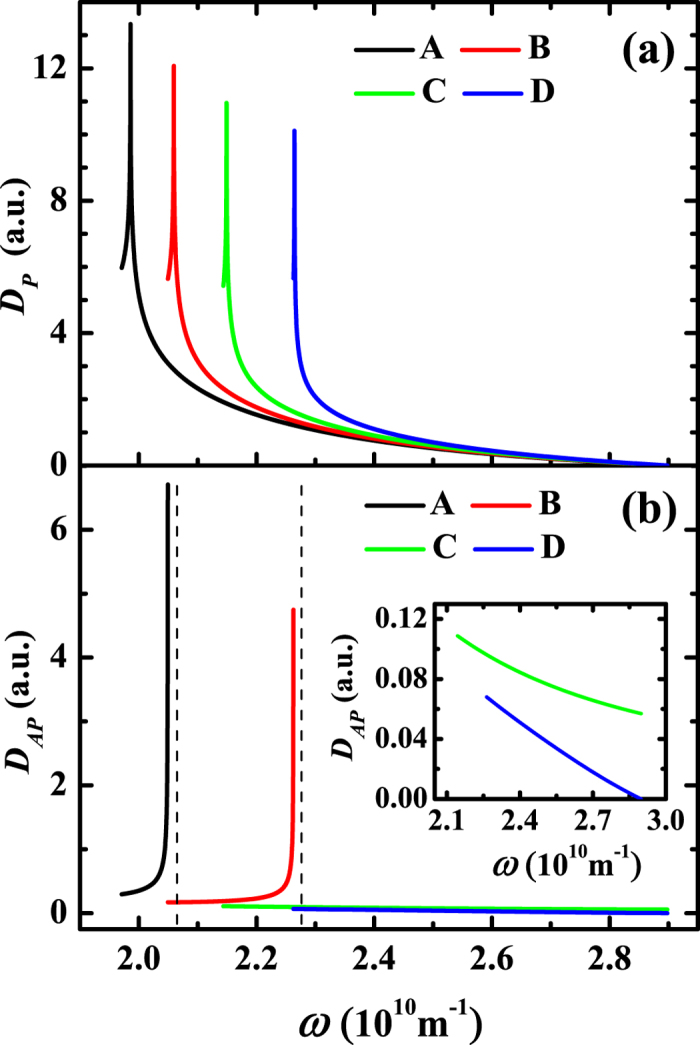
Spectral densities.(a)  and (b)  as functions of the oscillating frequency ω where Kh = 2.116 × 1010 m−1, v(Kh) = 16 eV and μ = 11 eV. The curves A, B, C, and D correspond to Δ = 10 eV, 9 eV, 8 eV and 7 eV, respectively. Here, the dashed lines denote the von Hove singularities, the inset is an enlarged view of the curves C and D.